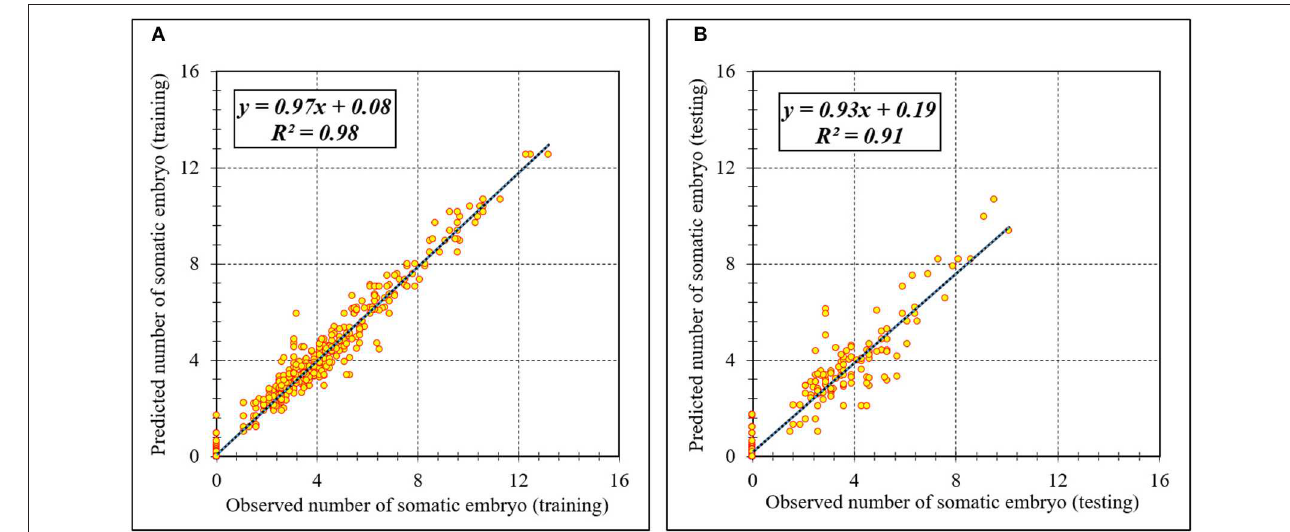
FIGURE 5 | Scatter plot of model predicted vs. observed values of number of somatic embryo of chrysanthemum obtained by ANFIS model. (A) Training set ( n = 810); (B) Testing set ( n = 270). Fitted simple regression line on scatter points was indicated by a solid line.